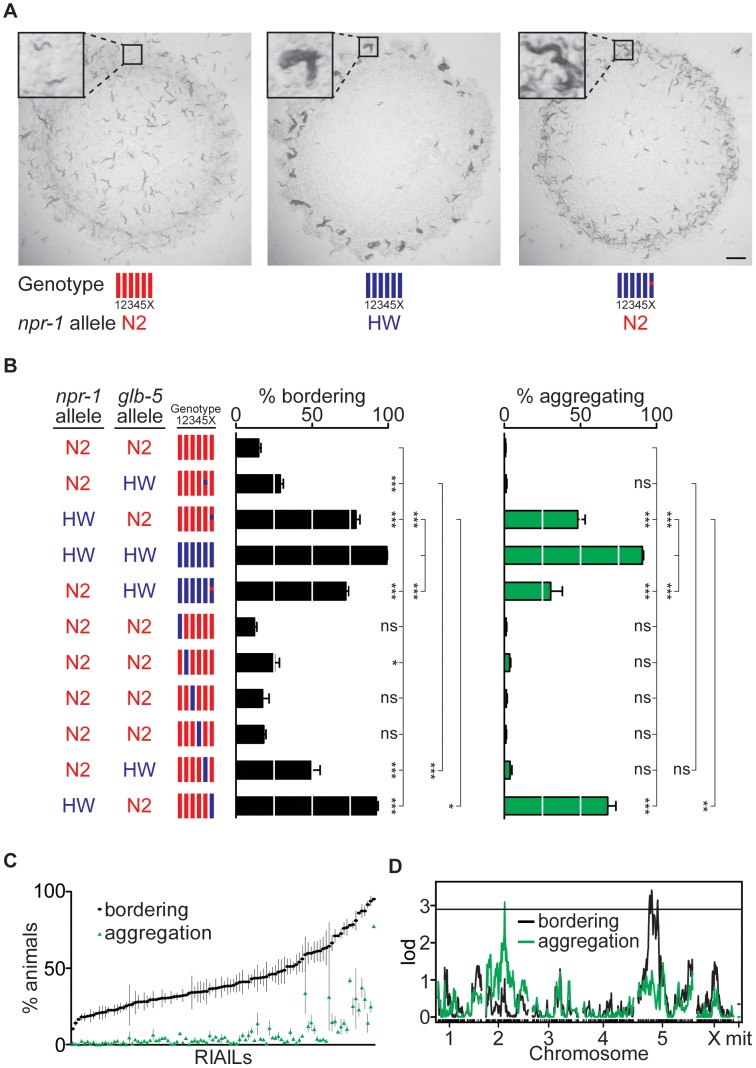
Identification of QTLs for social behavior.(A) Behavior of N2 animals (left), HW animals (middle), and HW animals with the N2 npr-1 allele (right). Photographs were taken three days after three adult hermaphrodites produced self-progeny on plates seeded with E. coli OP50. Scale bar, 2 mm. Insets show individual solitary N2 animals, a group of aggregating HW animals, and aggregating and non-aggregating animals from the HW strain with the N2 npr-1 allele. For genotypes in all figures, red denotes N2 DNA, blue denotes HW DNA. (B) Bordering and aggregation behaviors of npr-1 near-isogenic lines (NILs) and of chromosome-substitution strains. In this and other figures, bordering and aggregation were measured on 150 adult animals two hours after transferring to E. coli OP50 seeded plates (see Methods); values represent the mean of at least three assays per strain. Error bars, s.e.m. * P<0.05, ** P<0.01, *** P<0.001, by ANOVA with Bonferroni test. ns, not significant. (C) Behaviors of 102 N2-HW recombinant inbred advanced intercross lines (RIAILs) that carry the N2 npr-1 allele. (D) QTL analysis of RIAILs shown in (C). The horizontal line denotes the P<0.05 genome-wide significance threshold. lod, log likelihood ratio.